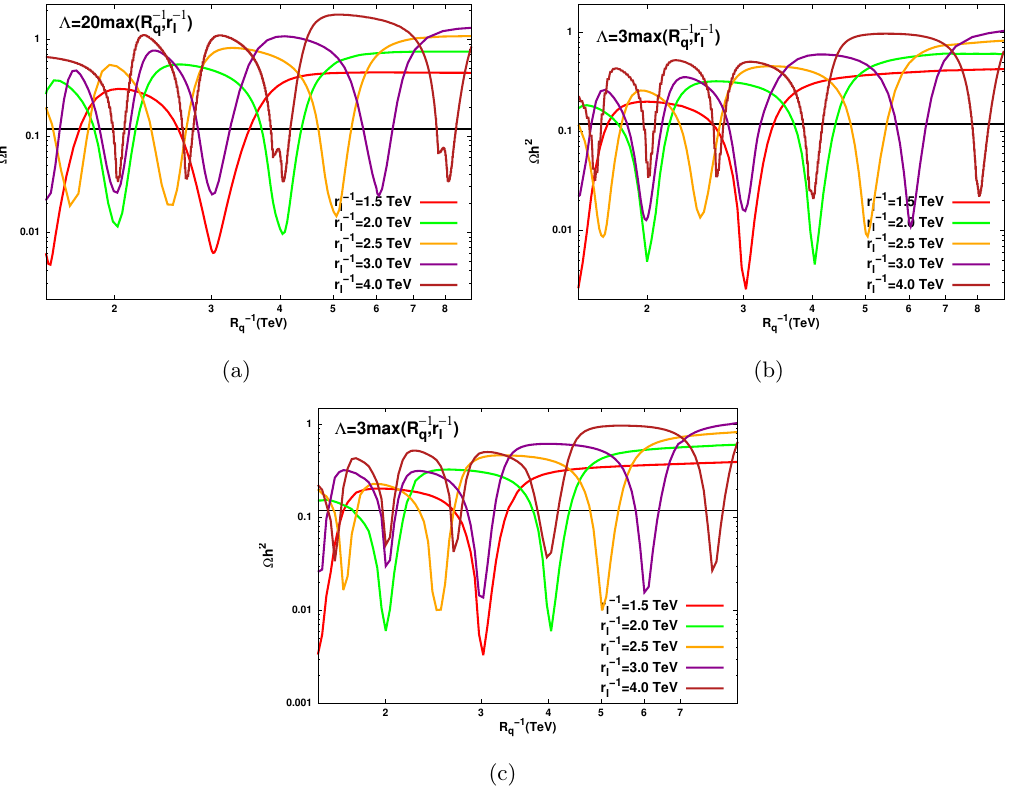
Figure 2 . (cid:10) h 2 as a function of R (cid:0) 1 values of the cuto(cid:11) (cid:3) for the case when Higgs is localized at the 4 corners. (c) corresponds to the bulk Higgs